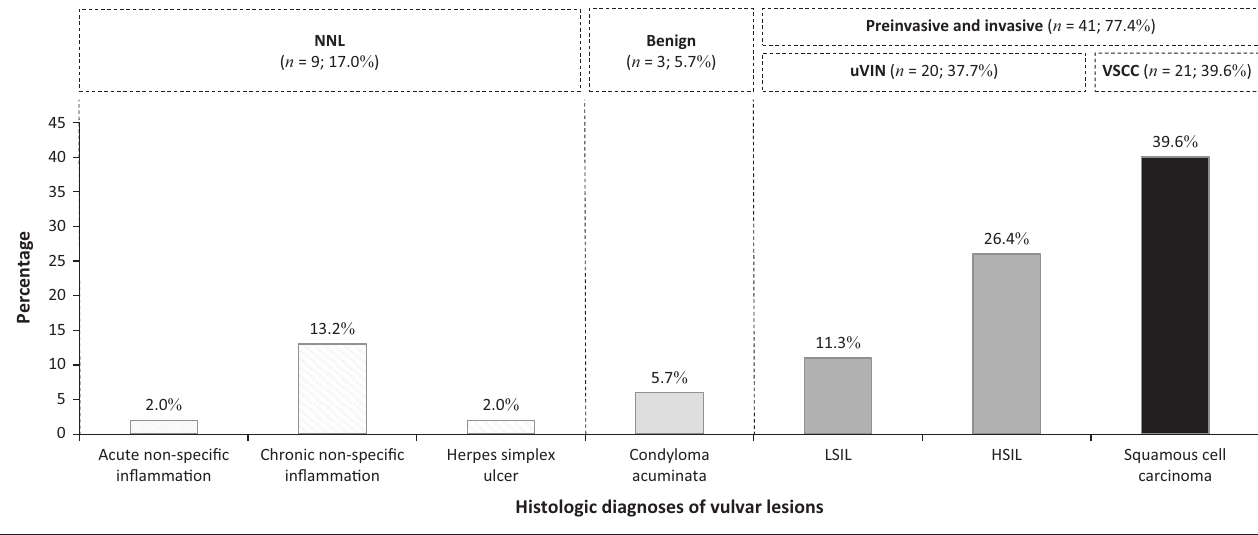
FIGURE 1: Histological diagnosis of vulvar lesions from women attending the University Teaching Hospital’s gynaecologic clinic, Zambia, 2018.